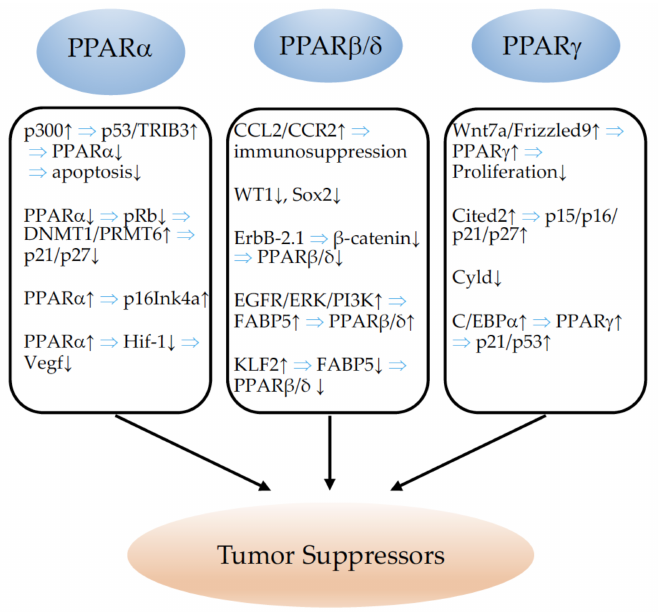
Figure 4. Illustration of the relationships between PPAR α , PPAR β / δ , and PPAR γ and tumor